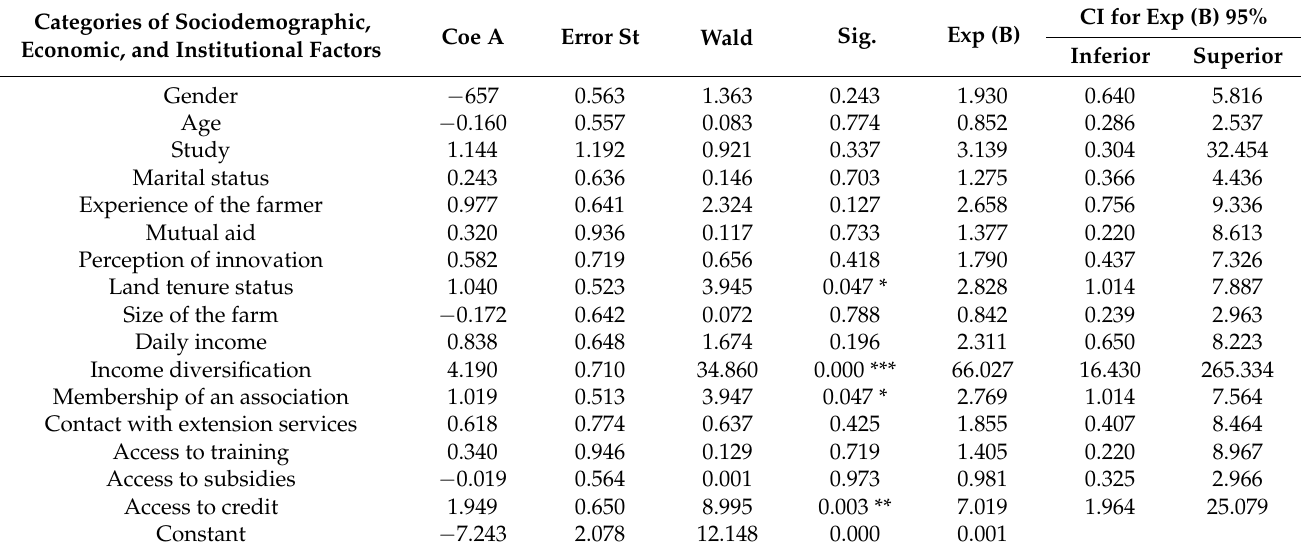
Table 7. Logit model estimation in motor pump use.